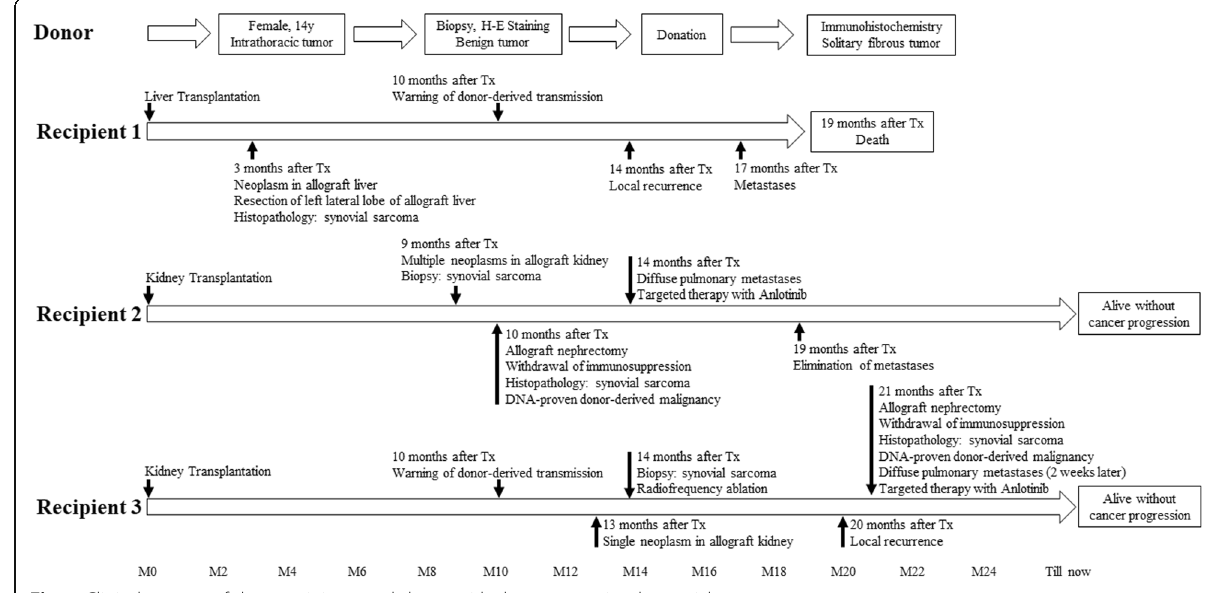
Fig. 1 Clinical courses of three recipients and donor with donor-transmitted synovial